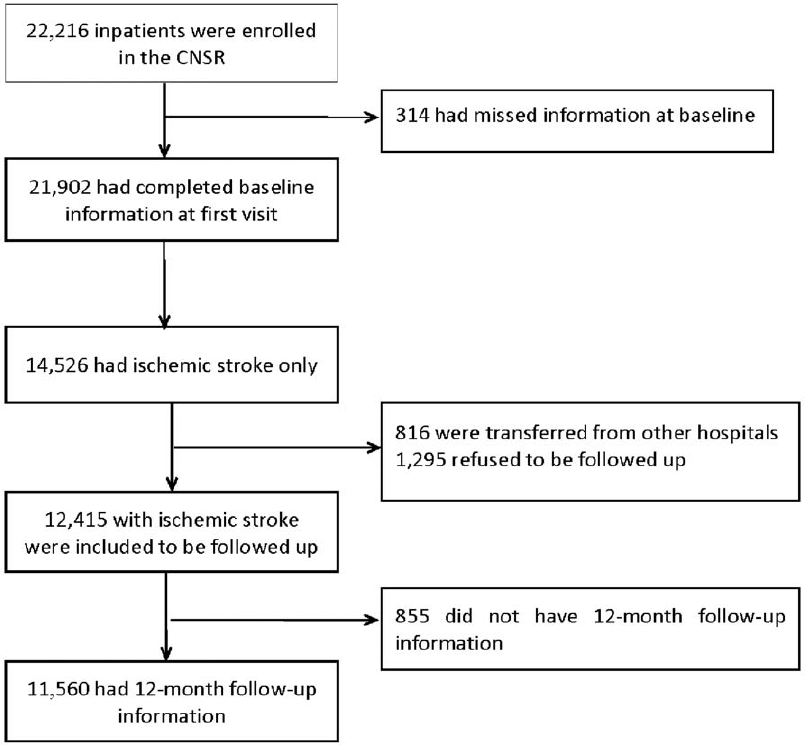
Figure 1. Flow diagram of participants.